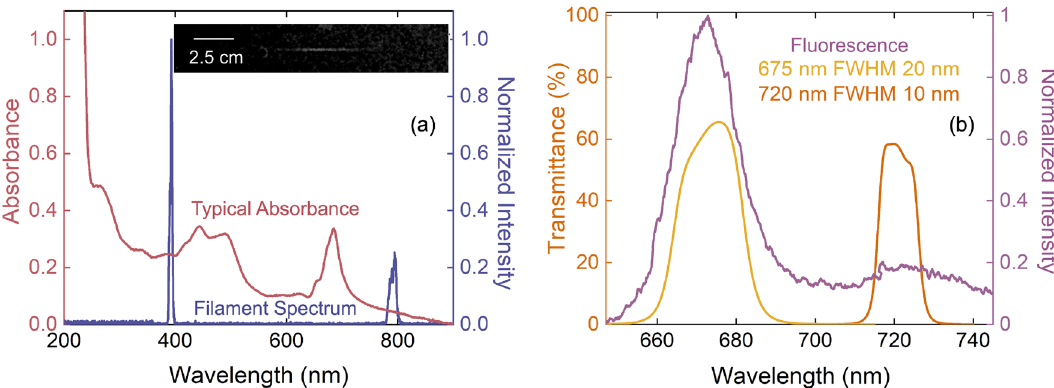
Figure 1. ( a ) Typical absorbance spectrum of C. reinhardtii and the filament excitation spectrum overlaid. The inset shows an image of the filament used for this experiment. ( b ) Example ChlF spectrum and the transmission spectra of the two spectral filters used for